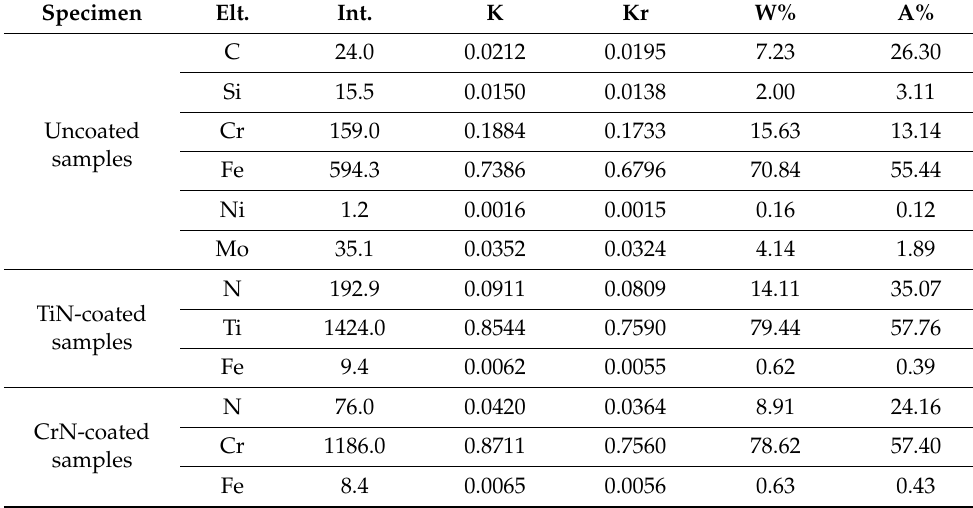
Table 4. EDX data from the coated and uncoated specimen